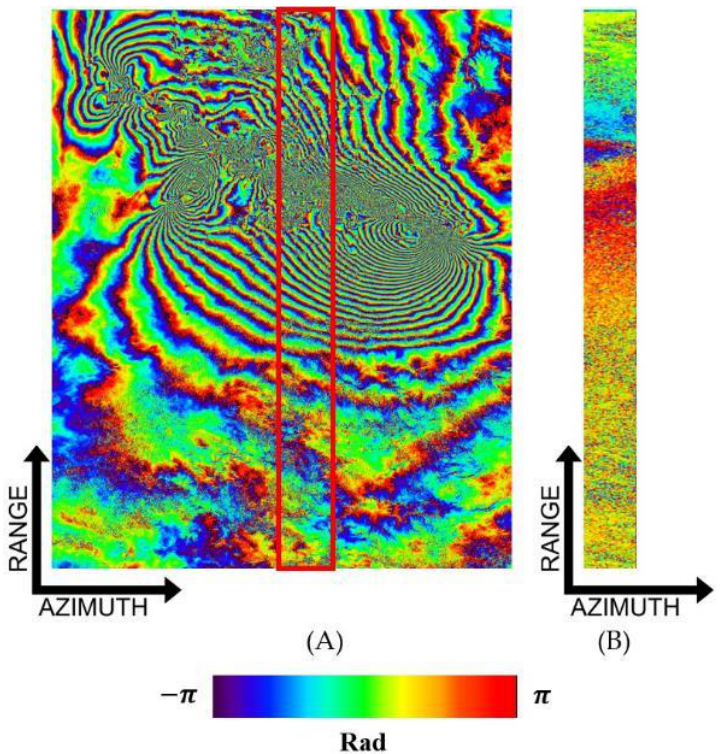
Figure 22. ( A ) Two-burst interferogram (non-stationary case) related to the Sentinel-1 SAR data pairs (11 May 2019 to 10 July 2019) of the area of Ridgecrest area ( B ) phase di ff erence between the two contiguous bursts in the overlapped region, highlighted with a red rectangle, before ESD application.